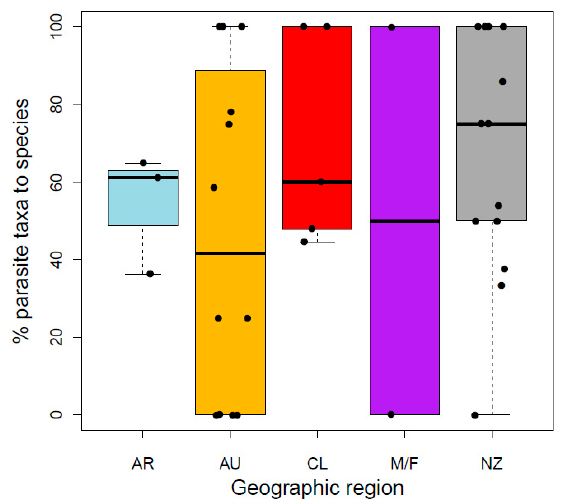
Figure 4. Percentage of parasite taxa described to species level in each galaxiid species per geographic region (AR Argentina, AU Australia, CL Chile, M/F Islas Malvinas/Falkland Islands, NZ New Zealand).